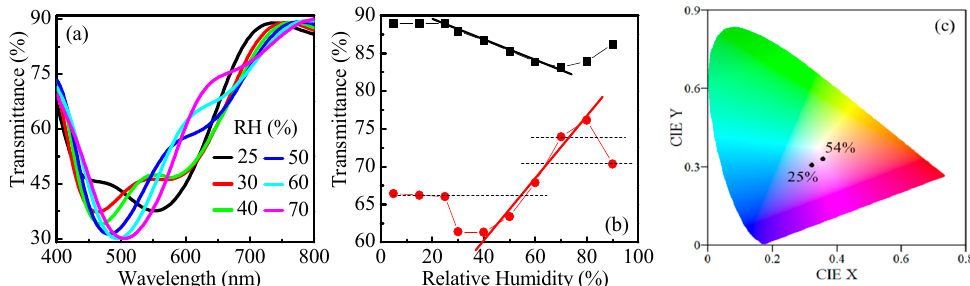
Figure 8. Transmittance spectra ( a ), transmittance values at λ max of 650 nm (red circles) and 730 nm (black squares), ( b ) and calculated CIE color coordinates ( c ) of 5-layer Bragg stacks top-covered with 300 nm polymer film exposed to denoted levels of relative humidity.